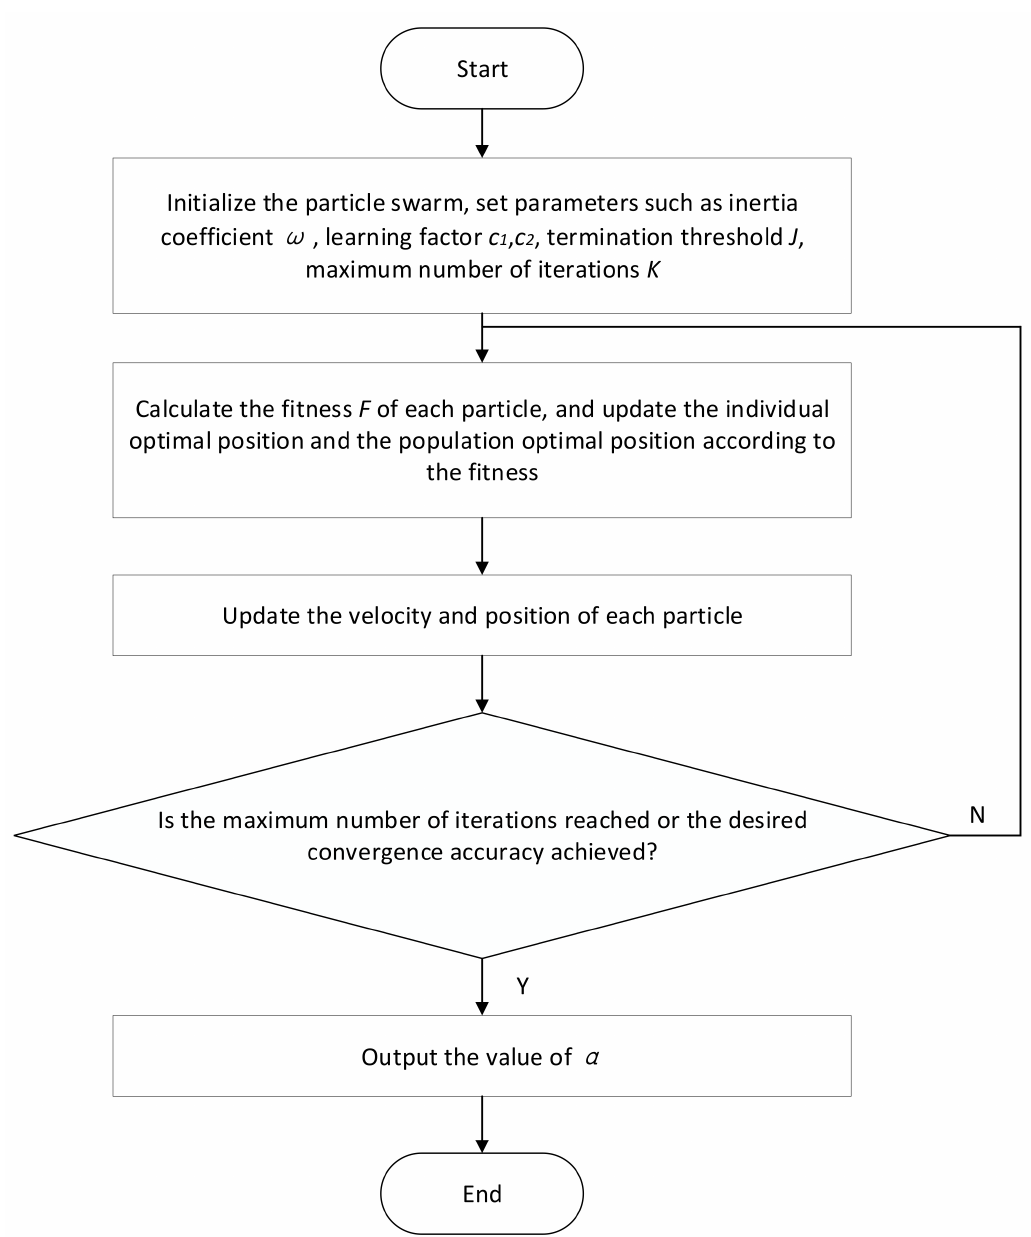
Figure 4. Flowchart of the PSO algorithm.